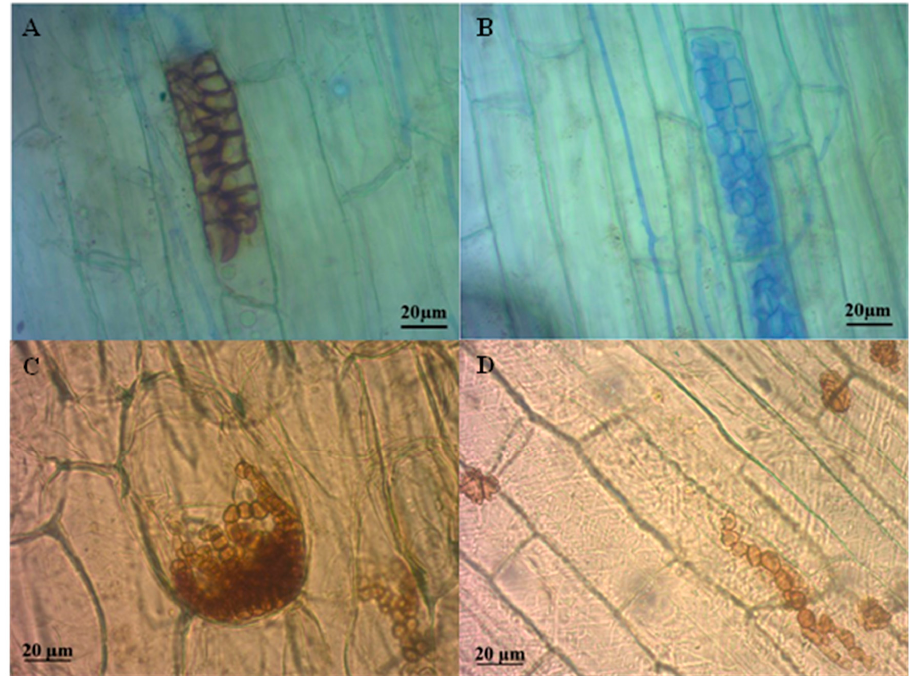
Figure 2. Colonization of sugarcane roots by dark septate endophytes in plants from the sugarcane producing region of Quatá, São Paulo, Brazil. Black arrows indicate melanized ( A ), hyaline colored with methyl blue ( B ), and forming ( C , D ) microsclerotia.